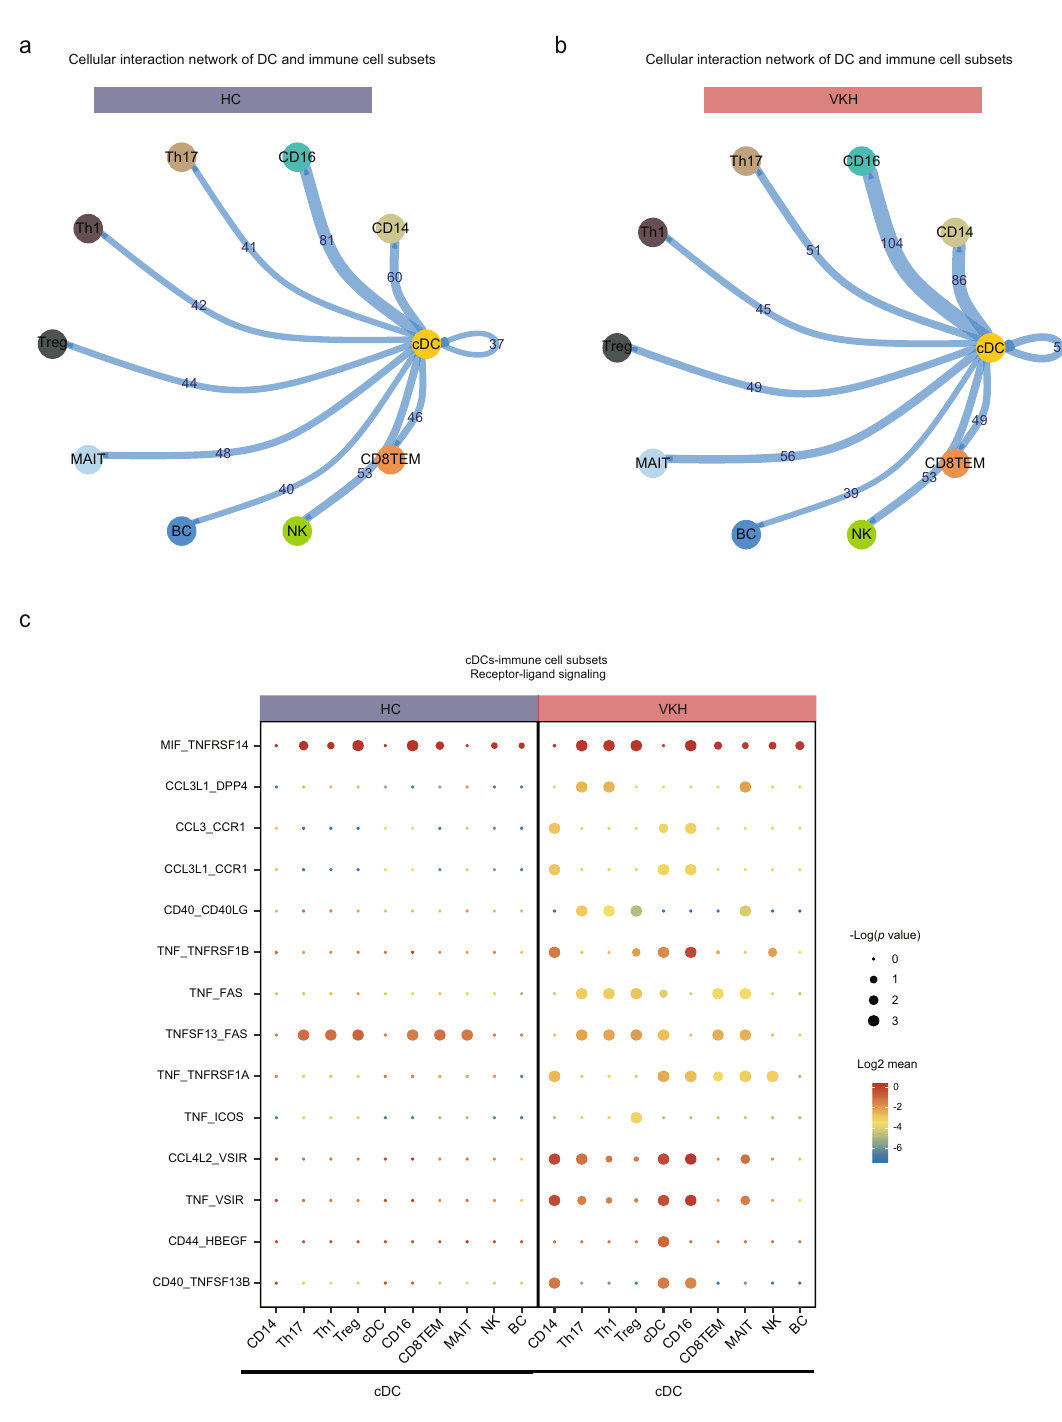
Fig. 7 The cDC-centric cellular communications of peripheral immune cells in HC and VKH. a Network plot showing the changes in ligand-receptor interaction events between cDCs and indicated immune cell types in the HC group. Cell-cell communication and the number of ligands and receptors are indicated by the connected line. b Network plot showing the changes in ligand-receptor interaction events between cDCs and indicated immune cell types in the VKH group. Cell-cell communication and the number of ligands and receptors are indicated by the connected line. c Dot plot of predicted interactions between cDCs and indicated immune cell types in HC and VKH. Circle sizes indicated p values. The expression levels of the interacted genes were indicated by colors, scales on the right. All data are aligned and annotated to hg38 reference